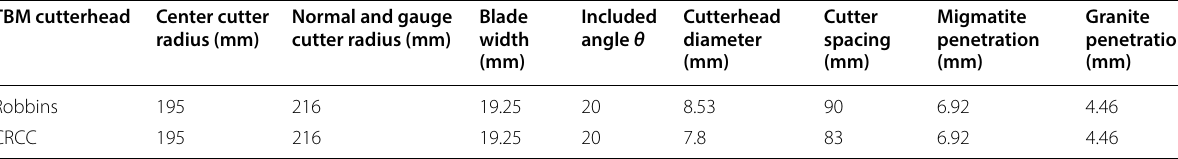
Table 3 Main parameters of two TBM cutterheads TBM cutterhead